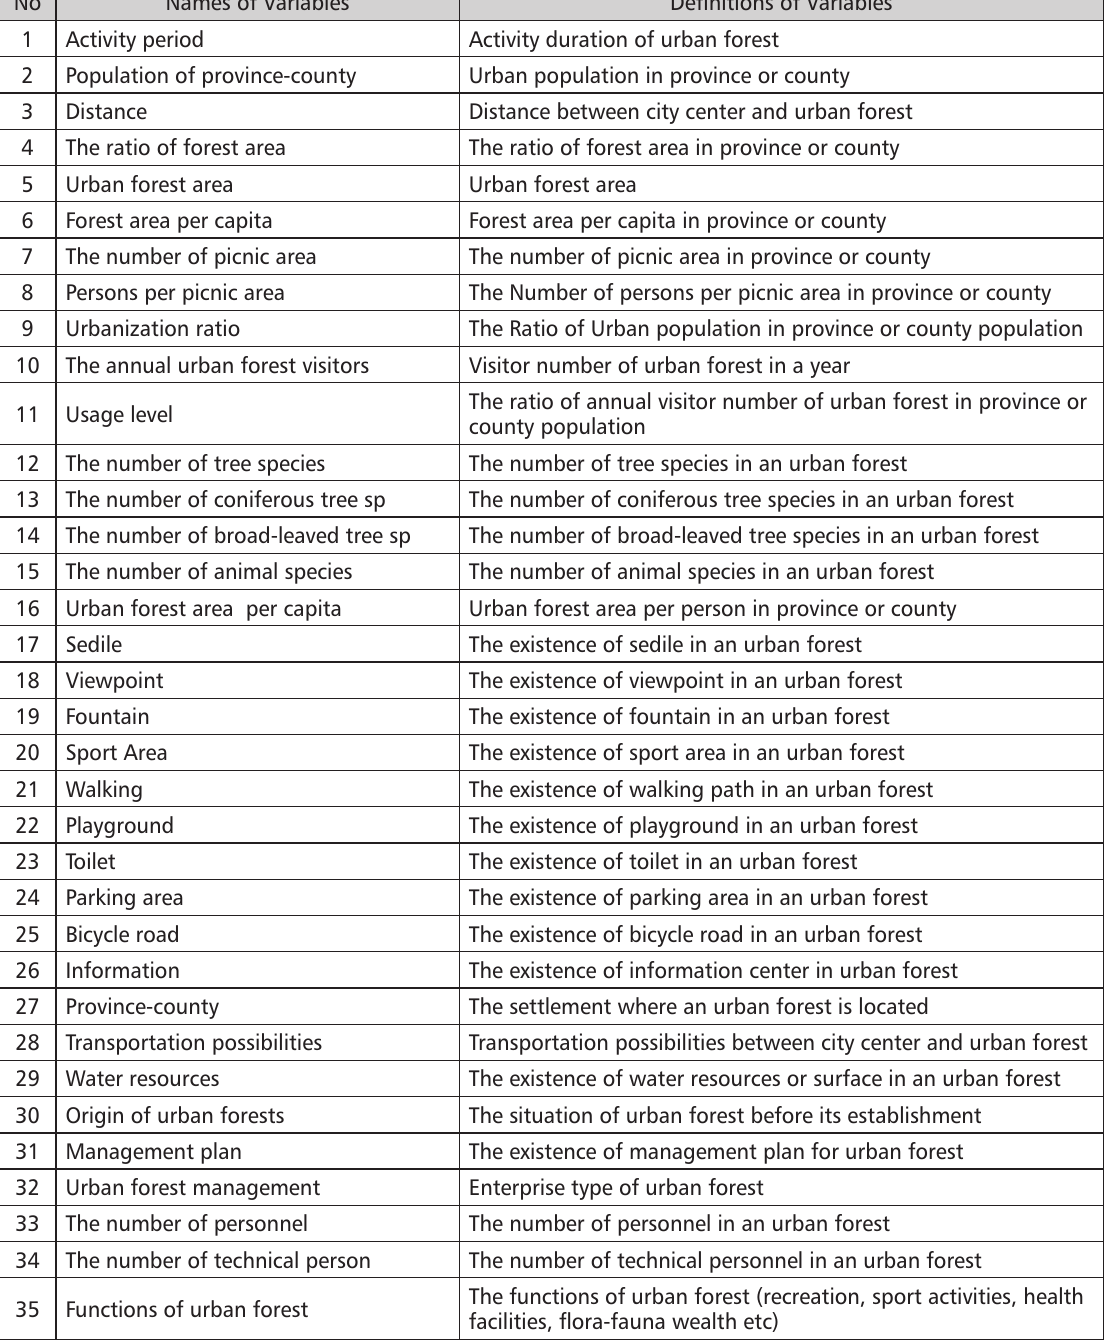
variables were calculated by using SPSS 16 (Statistical Package for the Social Sciences). The calculation